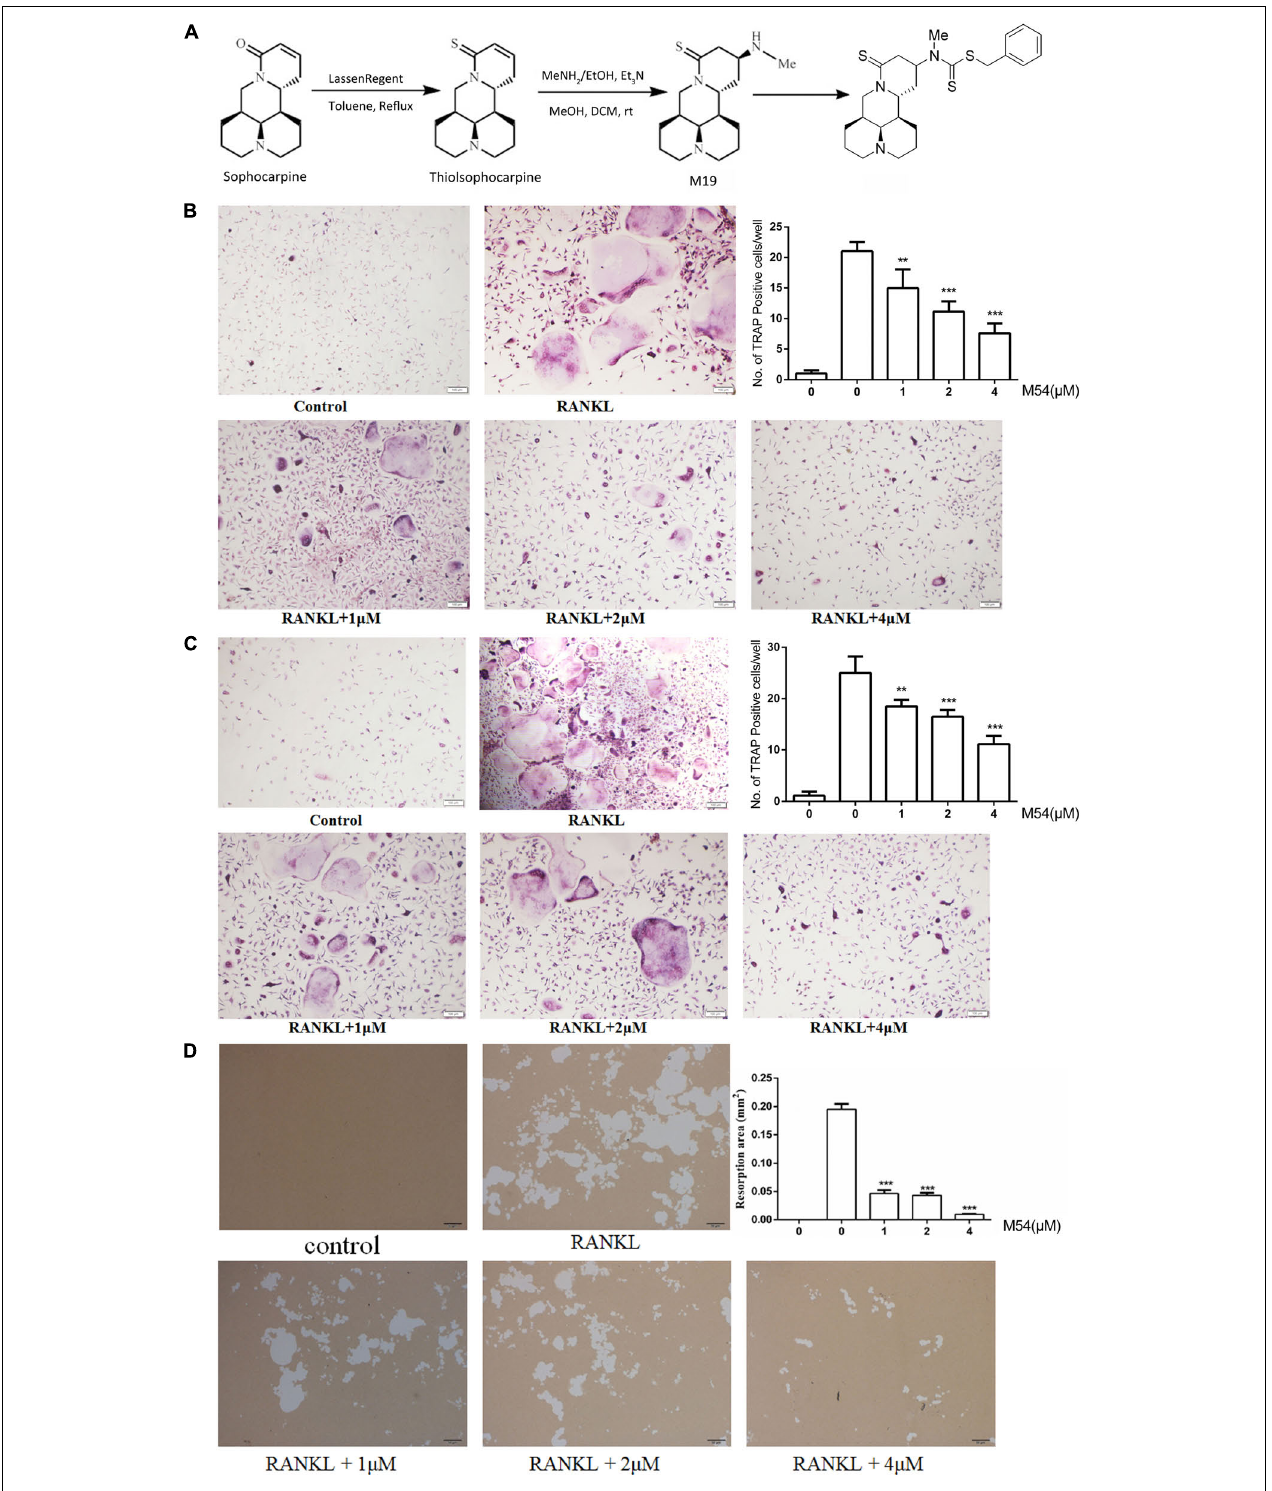
FIGURE 1 | M54 inhibits RANKL-induced osteoclast differentiation and bone resorption in vitro . (A) Chemical structure of M54 and the synthesis process. (B) Formation of TRAP-positive cells from BMMCs and the quantification of formed osteoclasts. (C) Formation of TRAP-positive cells from RAW264.7 cells and the quantification of formed osteoclasts. (D) The resorption area on the bone biomimetic synthetic surface was quantified by image analysis ( ∗ P < 0.05, ∗∗ P < 0.01, ∗∗∗ P < 0.001).